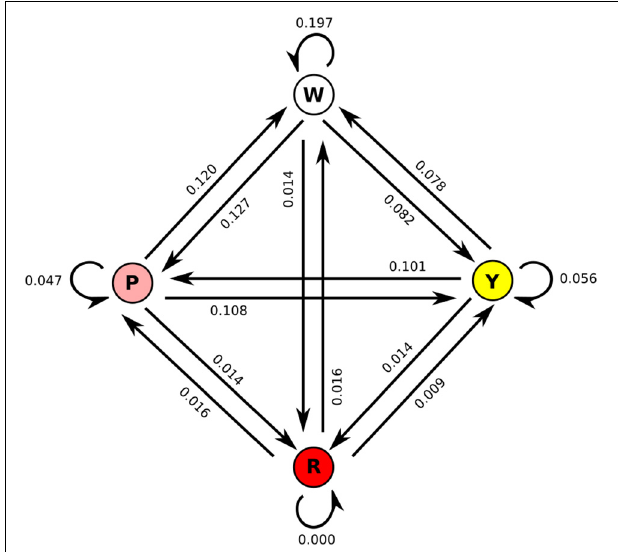
FIGURE 2 | State change diagram for the four floral colors, with values averaged across all moths. All values in the diagram sum to 1, i.e., the numbers are the proportion of all total changes, not of changes to/from each